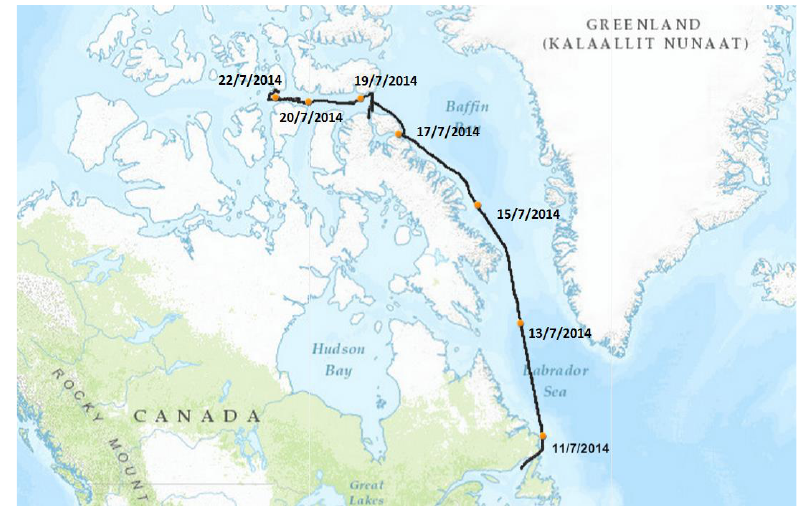
Figure 1. The route of CCGS Amundsen from 8 to 24 July 2014. Circles indicate sampling intervals for the high-volume sampler from 9 to 22 July (9–11, 11–13, 13–15, 15–17, 17–19, 20–22 July). The high-volume sampler was off because of stormy weather from 10:00 on 19 July to 10:00 on 20 July.